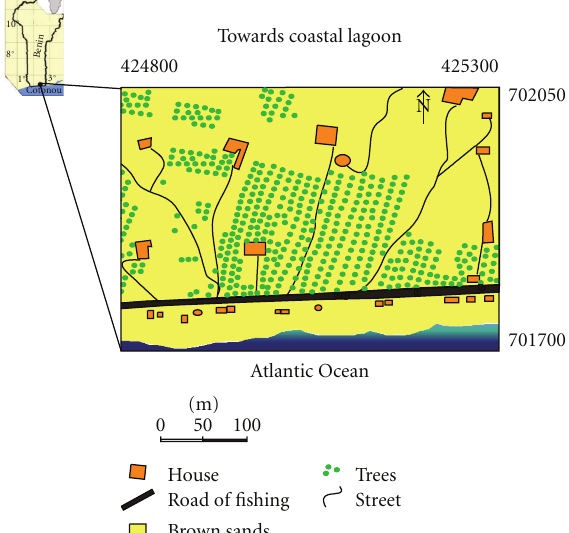
Figure 1: Study site map.